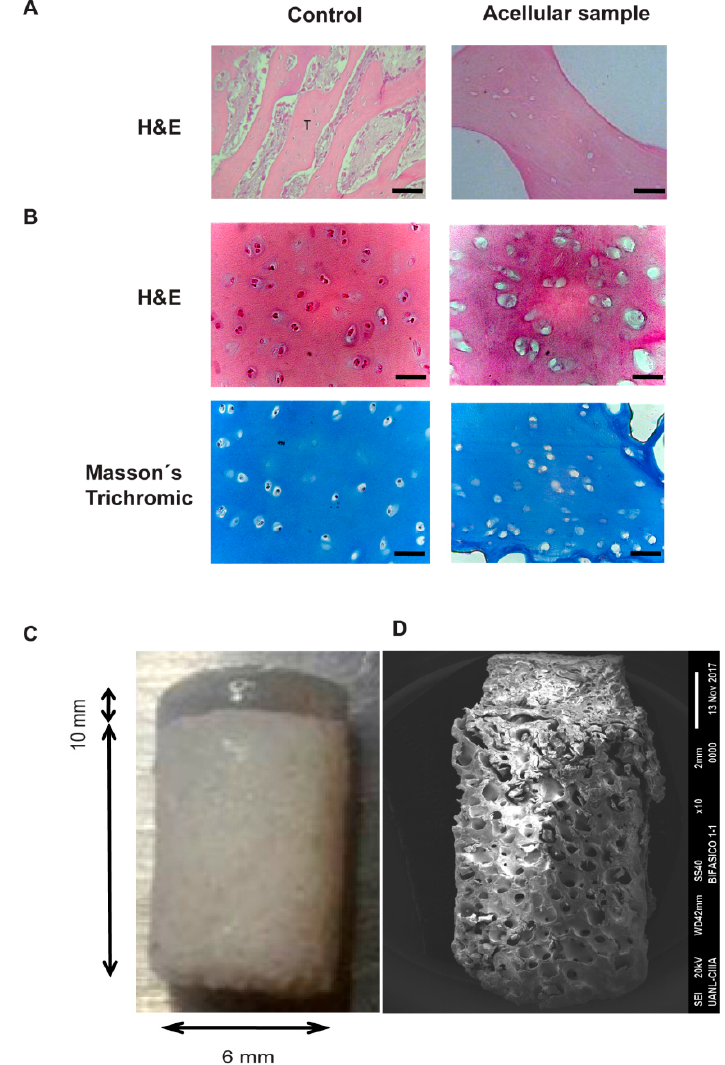
Figure 1 Decellularization of bone and cartilage, and biphasic scaffolding based on fibroin. The decellularization was assessed via an analysis of the H&E stained sections of ( A ) bone and ( B ) cartilage. Furthermore, in ( B ), the integrity of the cartilage matrix was appreciated by Massón’s trichromic stain. Scale bar = 50 µm. ( C ) The gross morphology of the biphasic acellular implant based on fibroin. The photographic image shows the dimension of the scaffolds. ( D ) The scanning electron microscope image shows the porous structure of the cartilage/bone scaffold.